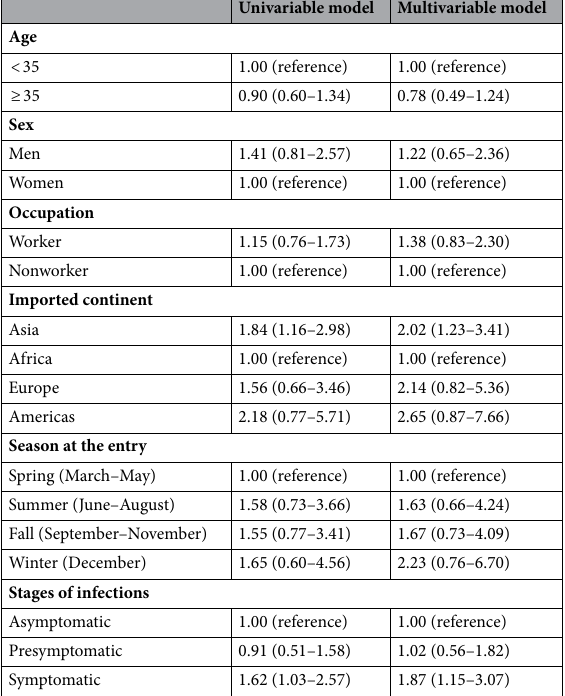
Table 2. Logistic regression analyses for factors associated with time to confirmation of imported COVID-19 cases in Chengdu, China. Data are presented as odds ratios (95% confidence